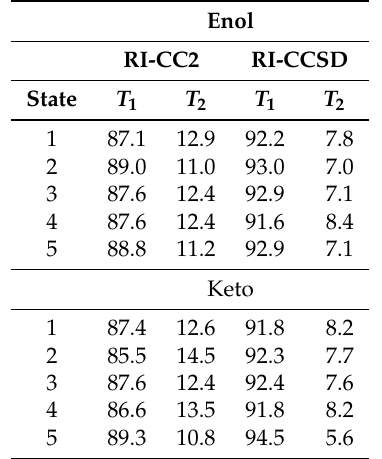
Table A3. Contributions of the T 1 and T 2 clusters to the RI-CC2 and RI-CCSD excited states of the enol and keto forms of the isolated PYV3 [PYV3] molecule (in %), as calculated with the def2-TZVPD basis